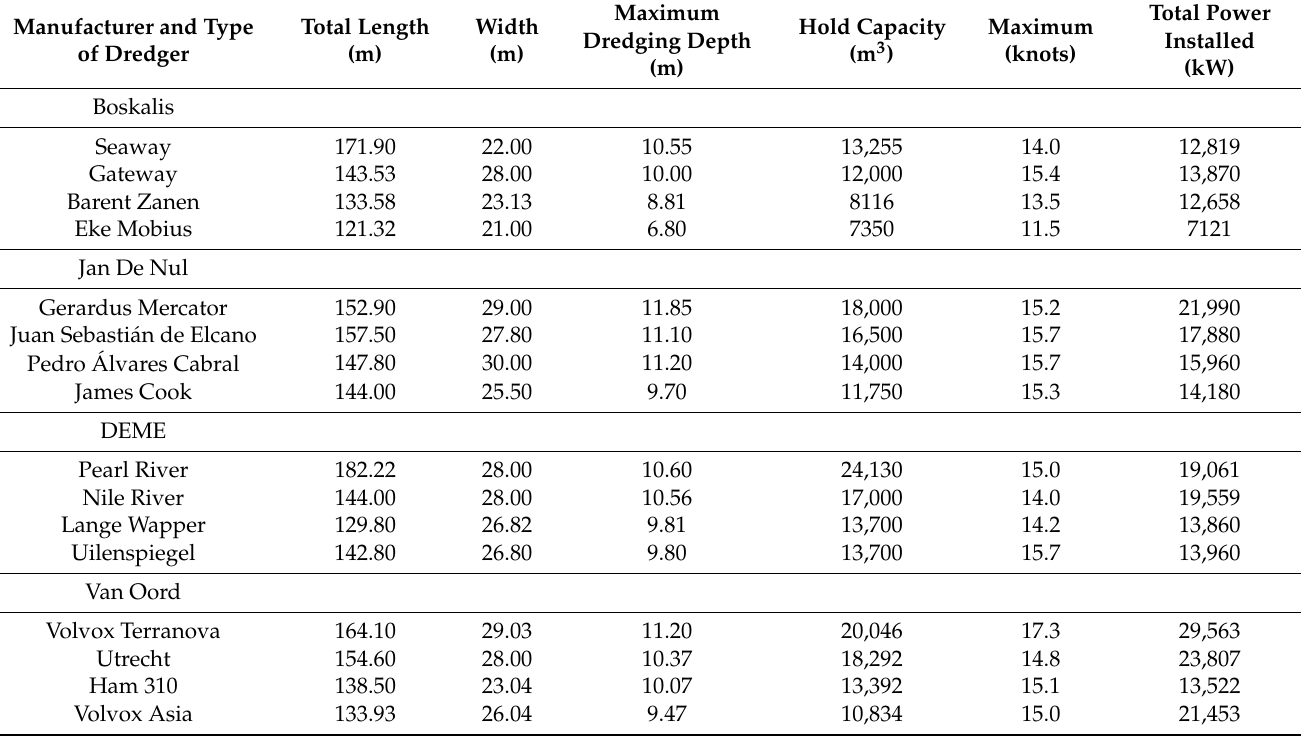
Table 2. Decision matrix for dredger